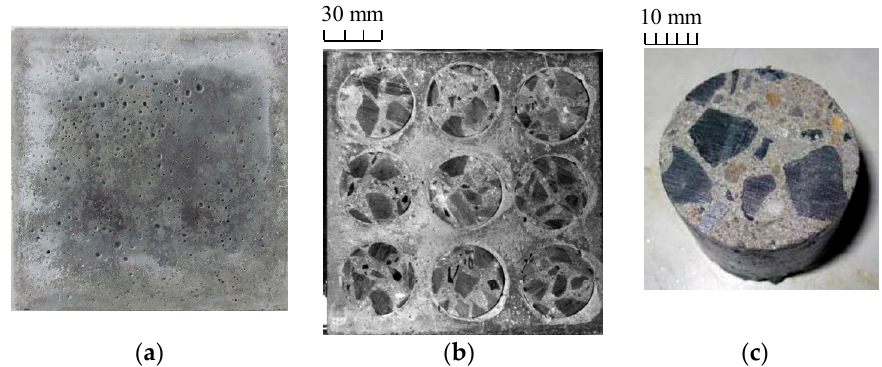
Figure 1. ( a ) cement mortar; ( b ) modeled recycled aggregate concrete; ( c ) recycled aggregate.